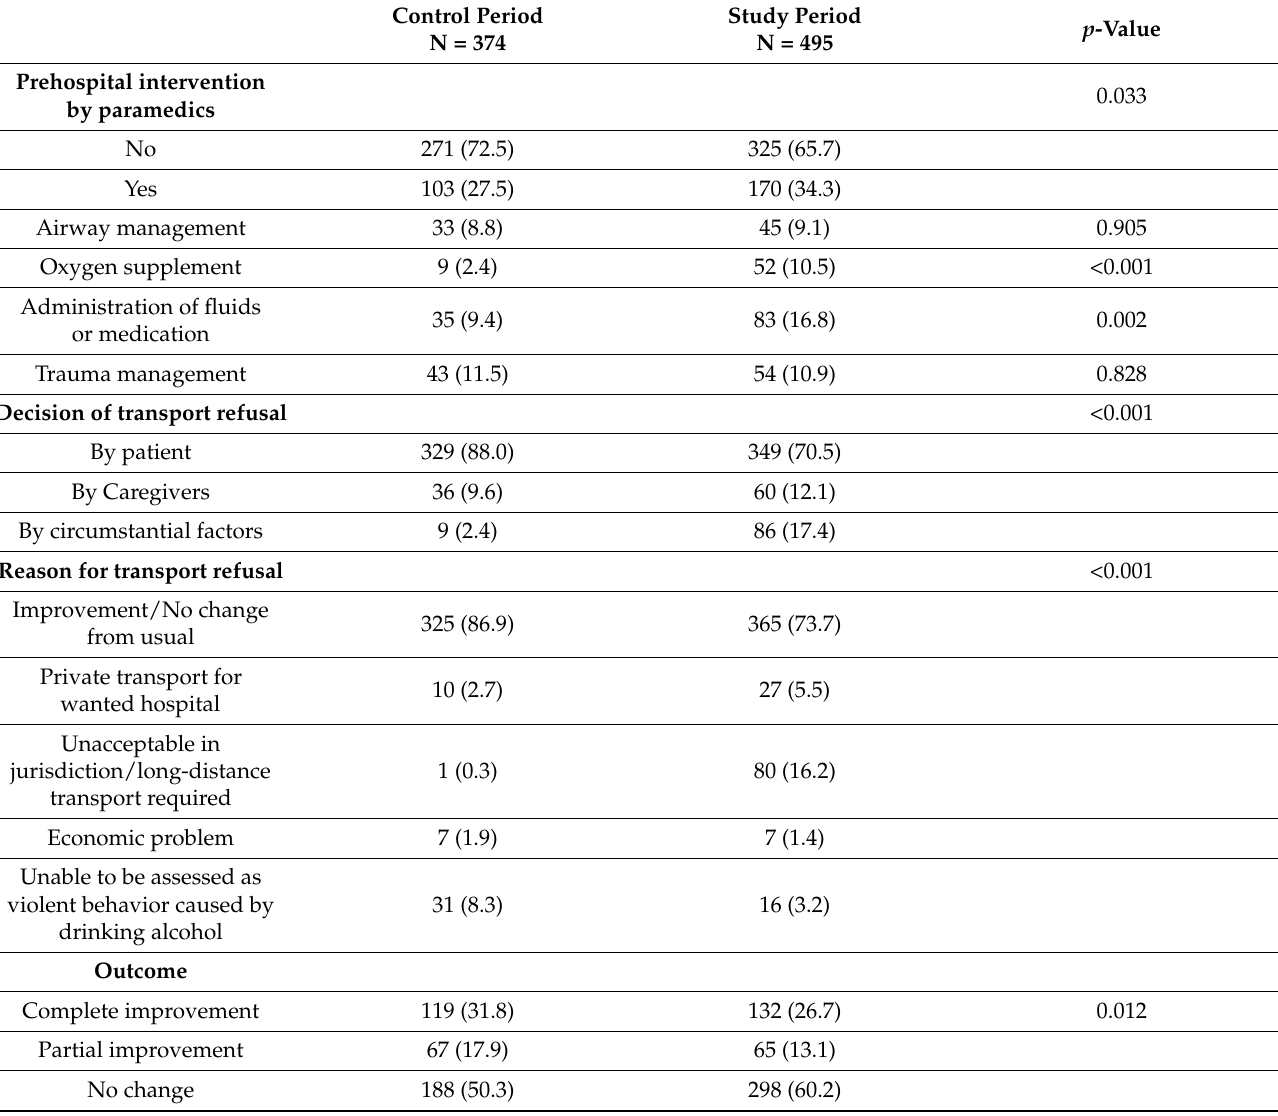
Table 4. Case analysis of transport failure in critically ill